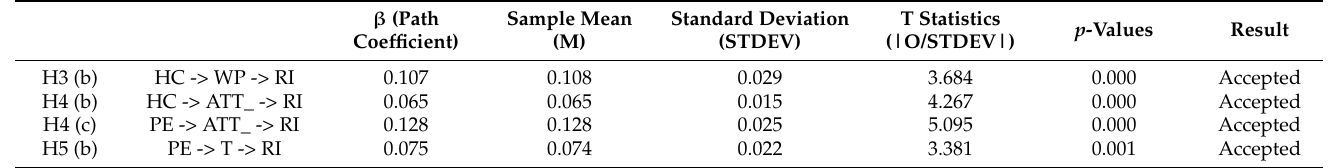
Table 7. Specific indirect